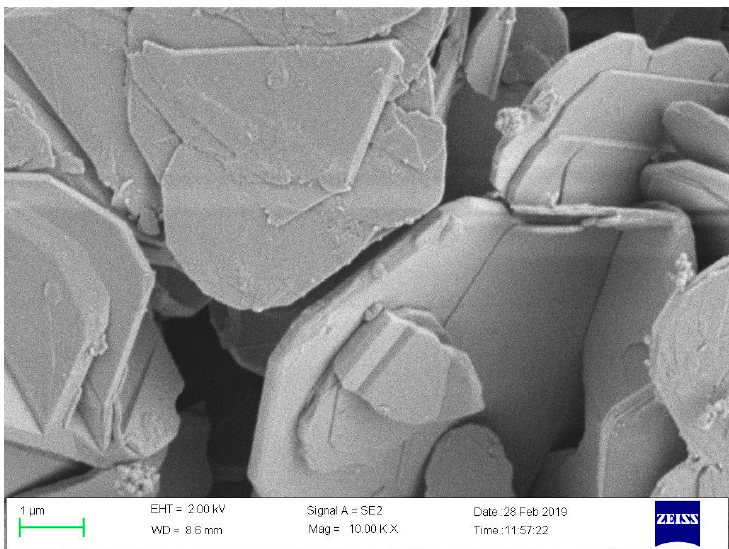
Figure 1. SEM image of pristine epoxy resin (EP) with BN nanosheets (BNNSs).